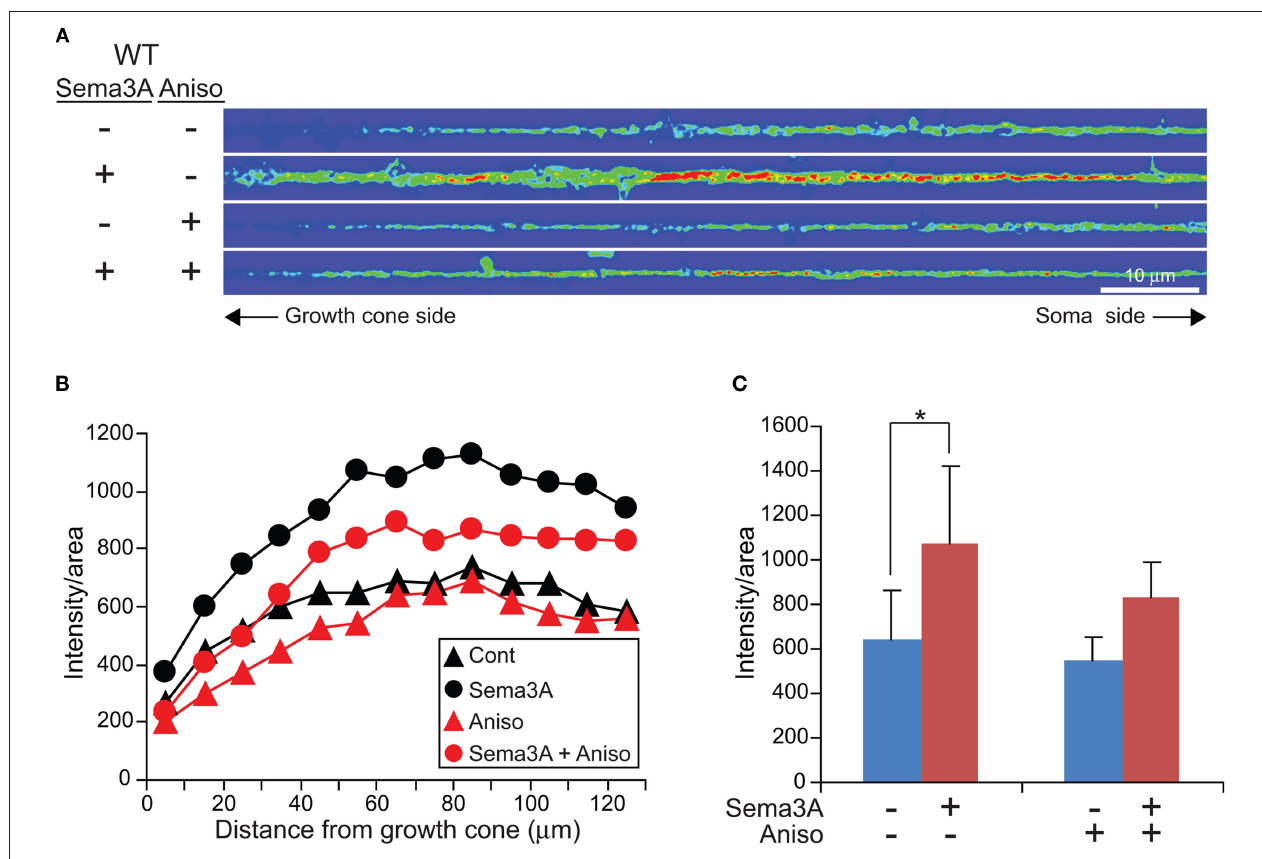
FIGURE 4 | Sema3A increased MAP1B levels in distal axons of wild type neurons in a protein synthesis-dependent manner. (A) MAP1B IF images of straightened axons treated with or without 1 nM Sema3A for 5 min in WT neurons in the presence or absence of anisomycin (Aniso). (B) Fluorescent